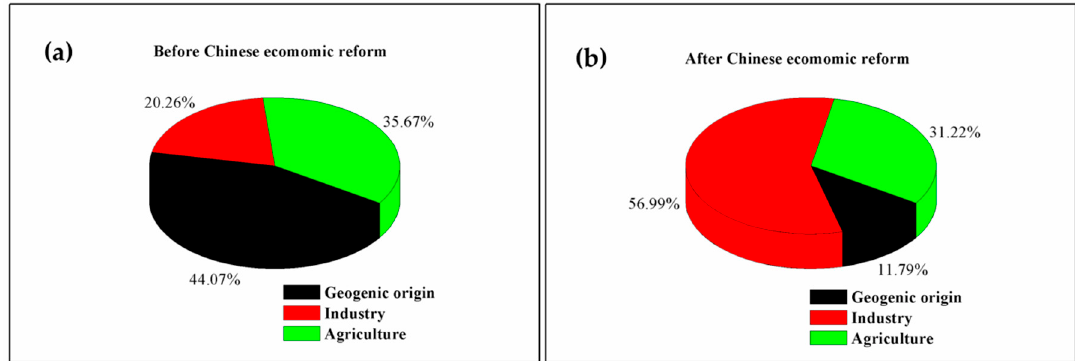
Figure 6. Sources of sediment heavy metals before and after the Chinese economic reform. ( a ) before Chinese economic reform; ( b ) after Chinese economic reform.